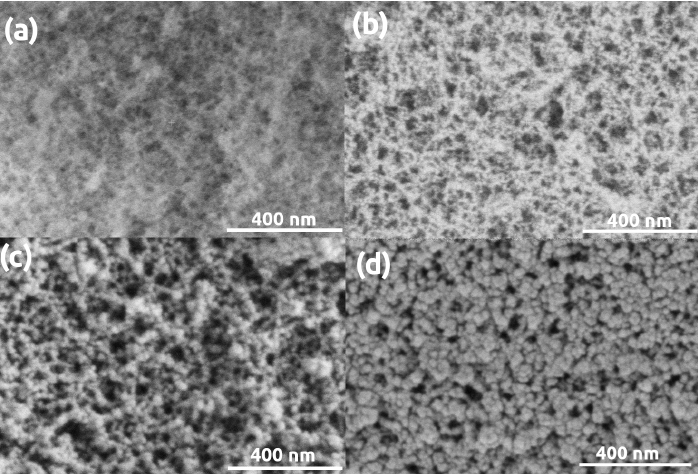
Figure 1. Low Voltage Scanning Electron Microscopy (LVSEM) images of silica aerogel samples. ( a ) Pristine, uncoated. ( b – d ) Sputter coated with 5 nm, 16 nm, 32 nm thick Au layers,